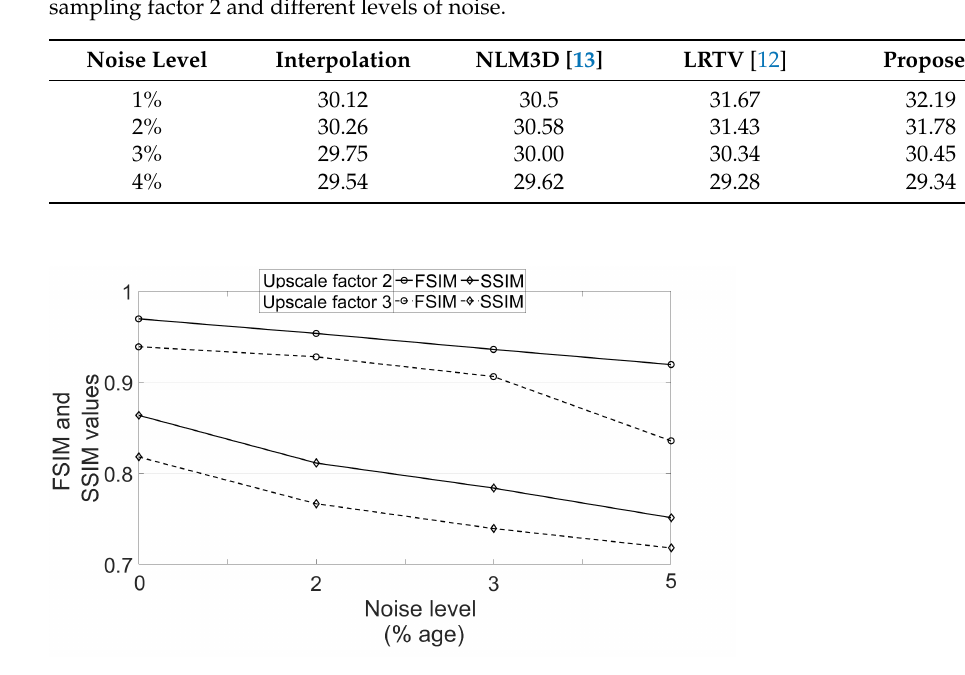
Figure 14. Analysis of FSIM and SSIM values for different noise variances and upscale